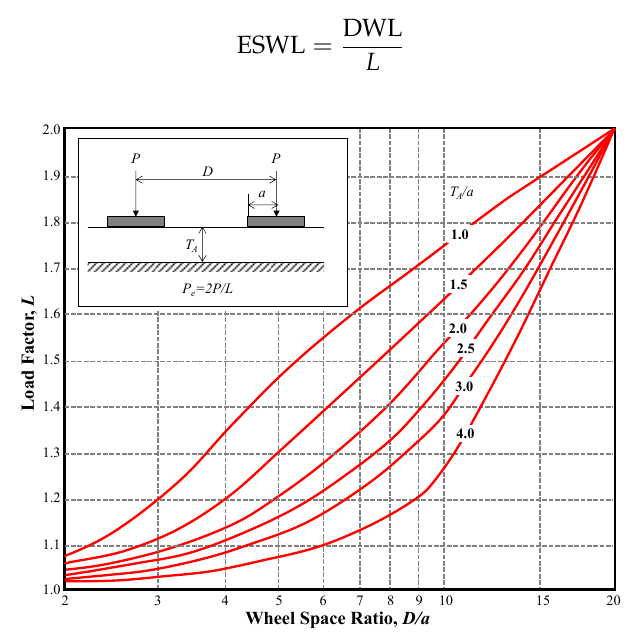
Figure 3. Dual-wheel load factors.